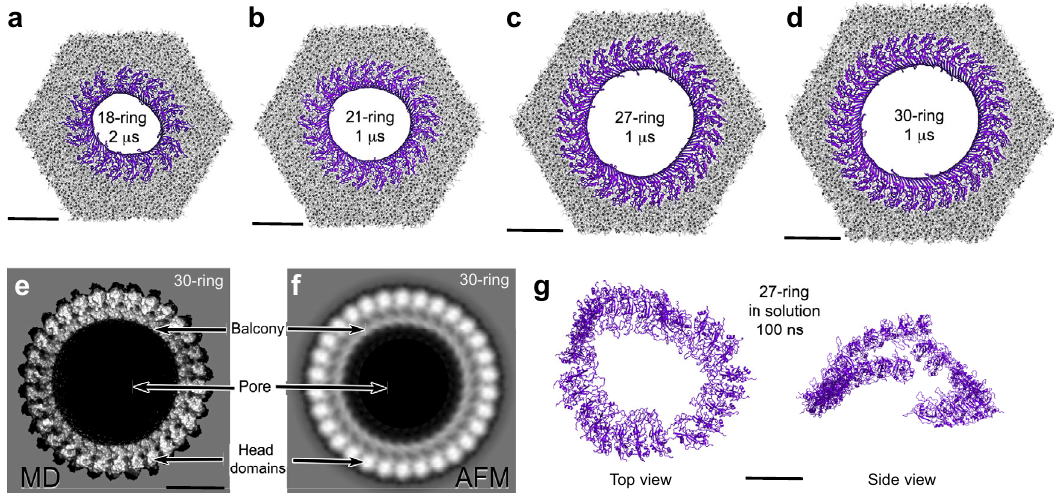
Fig. 5 mGSDMA3 Nterm oligomers reshape into more stable assemblies. a – d All-atom MD simulations of membrane-inserted ring-shaped oligomers encompassing 18, 21, 27 and 30 mGSDMA3 Nterm and reshaping after indicated times. Views are from cytosolic surface. E. coli polar lipid extract membranes are shown in gray, mGSDMA3 Nterm in purple. e Topograph of membrane-inserted ring-shaped oligomer of 30 mGSDMA3 Nterm averaged from 4000 oligomers from one MD simulation after exclusion of the fi rst 100 ns. f Correlation symmetrized average of AFM topographs of 18 membrane- inserted ring-shaped mGSDMA3 Nterm oligomers showing 30-fold symmetry (Fig. 4d). g Ring-shaped oligomer without β -barrel disassembles in solution within 100 ns. Scale bars, 10